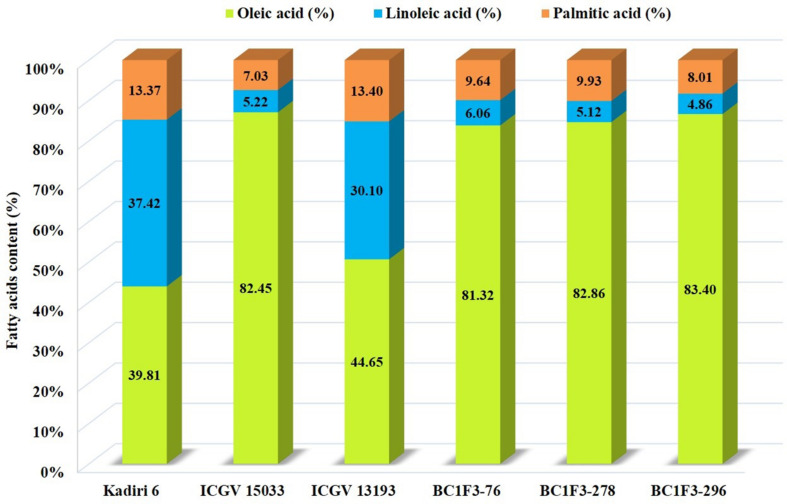
Fatty acid profiles of parental lines and selected backcrossed lines.